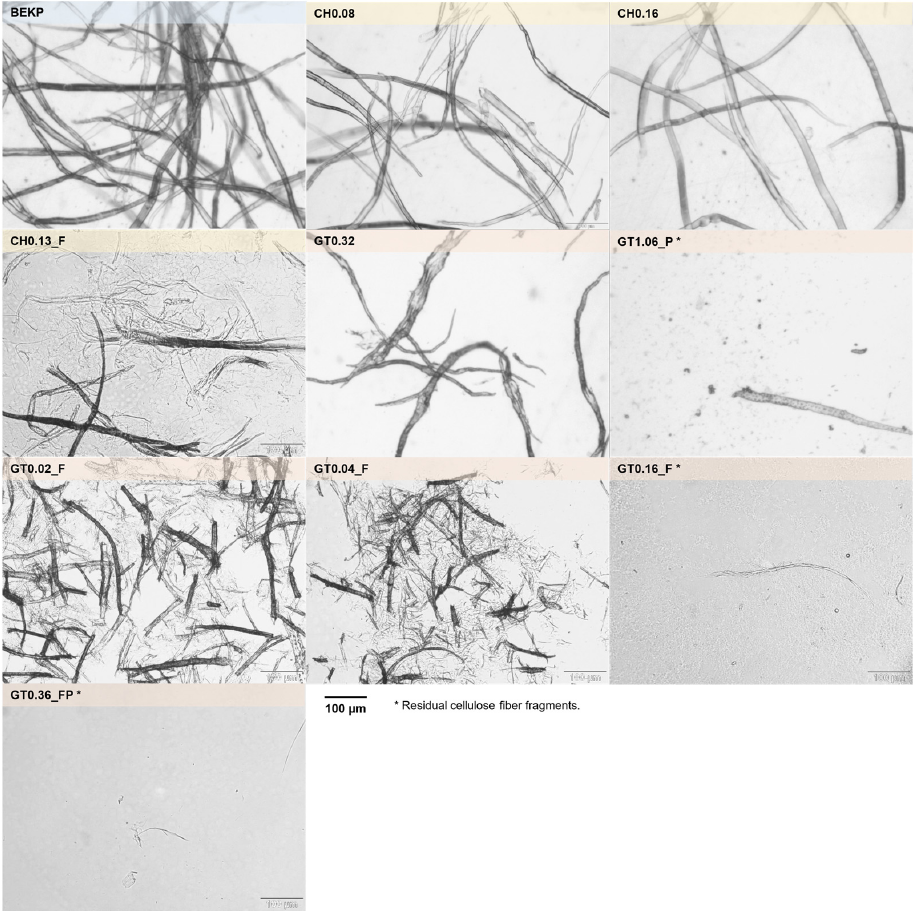
Figure 4. Optical microscopy images of the original BEKP and celluloses cationized with CHPTAC and GT (* Residual cellulose fiber fragments).